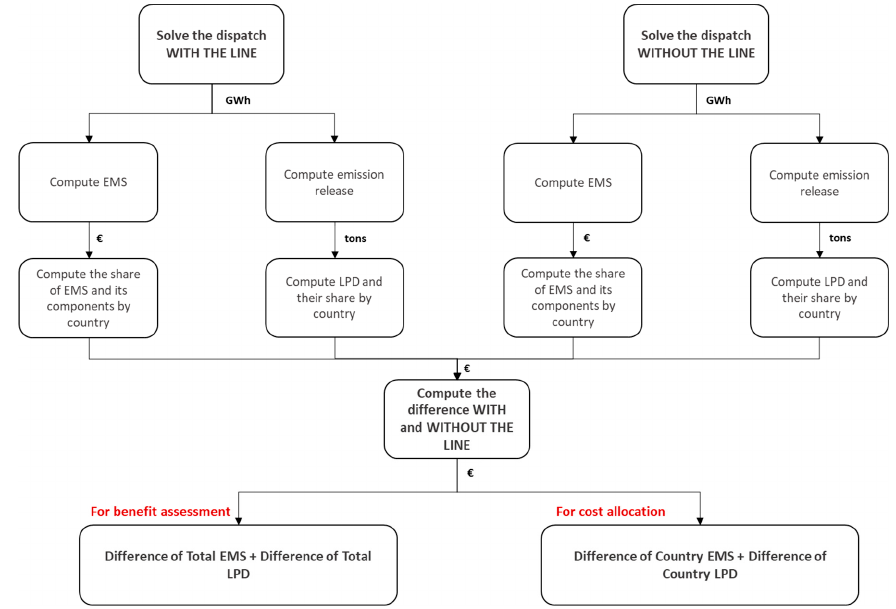
Figure 1. Steps of the assessment of the benefits of a transmission